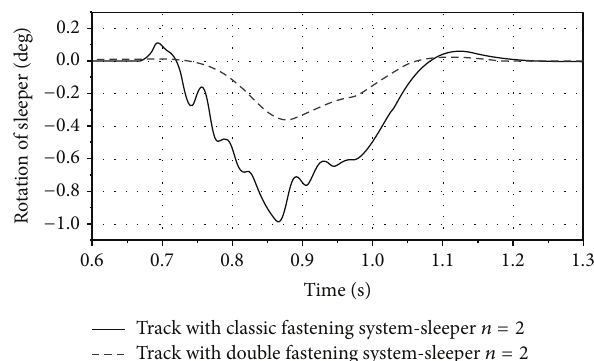
Figure 8: Comparison of rotation of two sleepers with different weight and fastening systems—vehicle speed 20 m/s.